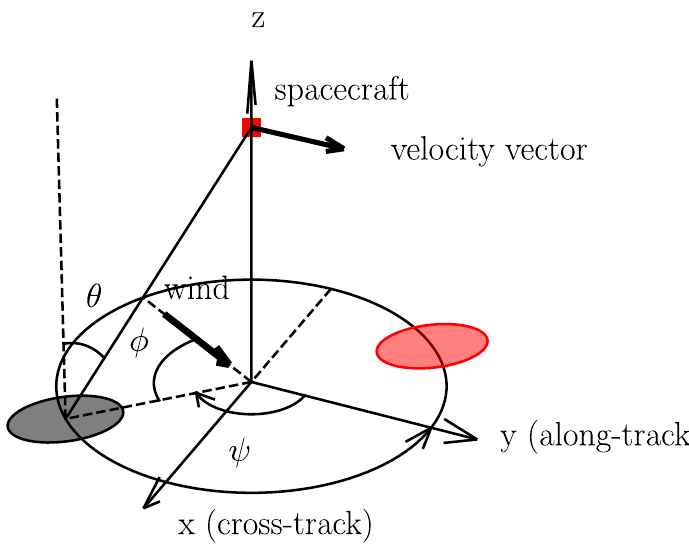
Figure 1. Schematic representation of the geomtery of a conically scanning spaceborne pencil-beam scatterometer in a reference system centered around the spacecraft’s nadir. The spacecraft is represented by the red square, and the red (gray) ellipse represents the antenna footprint in acquisition mode fore (aft). ψ represents the antenna azimuth angle, φ the relative wind direction and θ is the incidence angle.